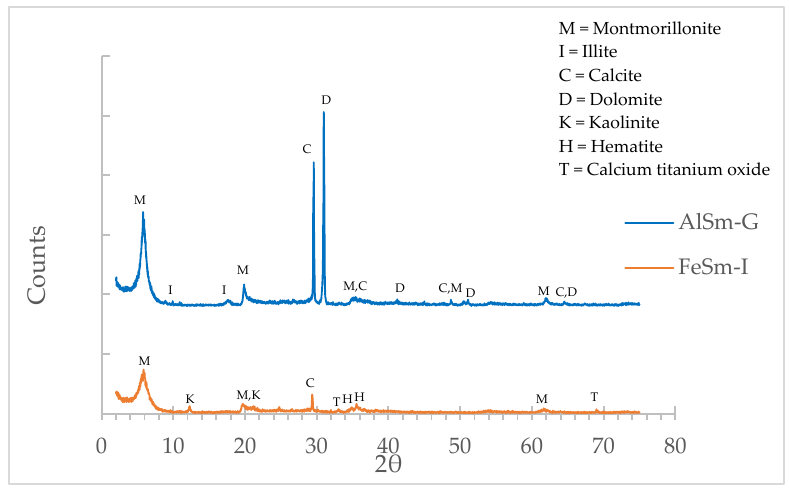
Figure 1. X-ray diffraction of raw materials.